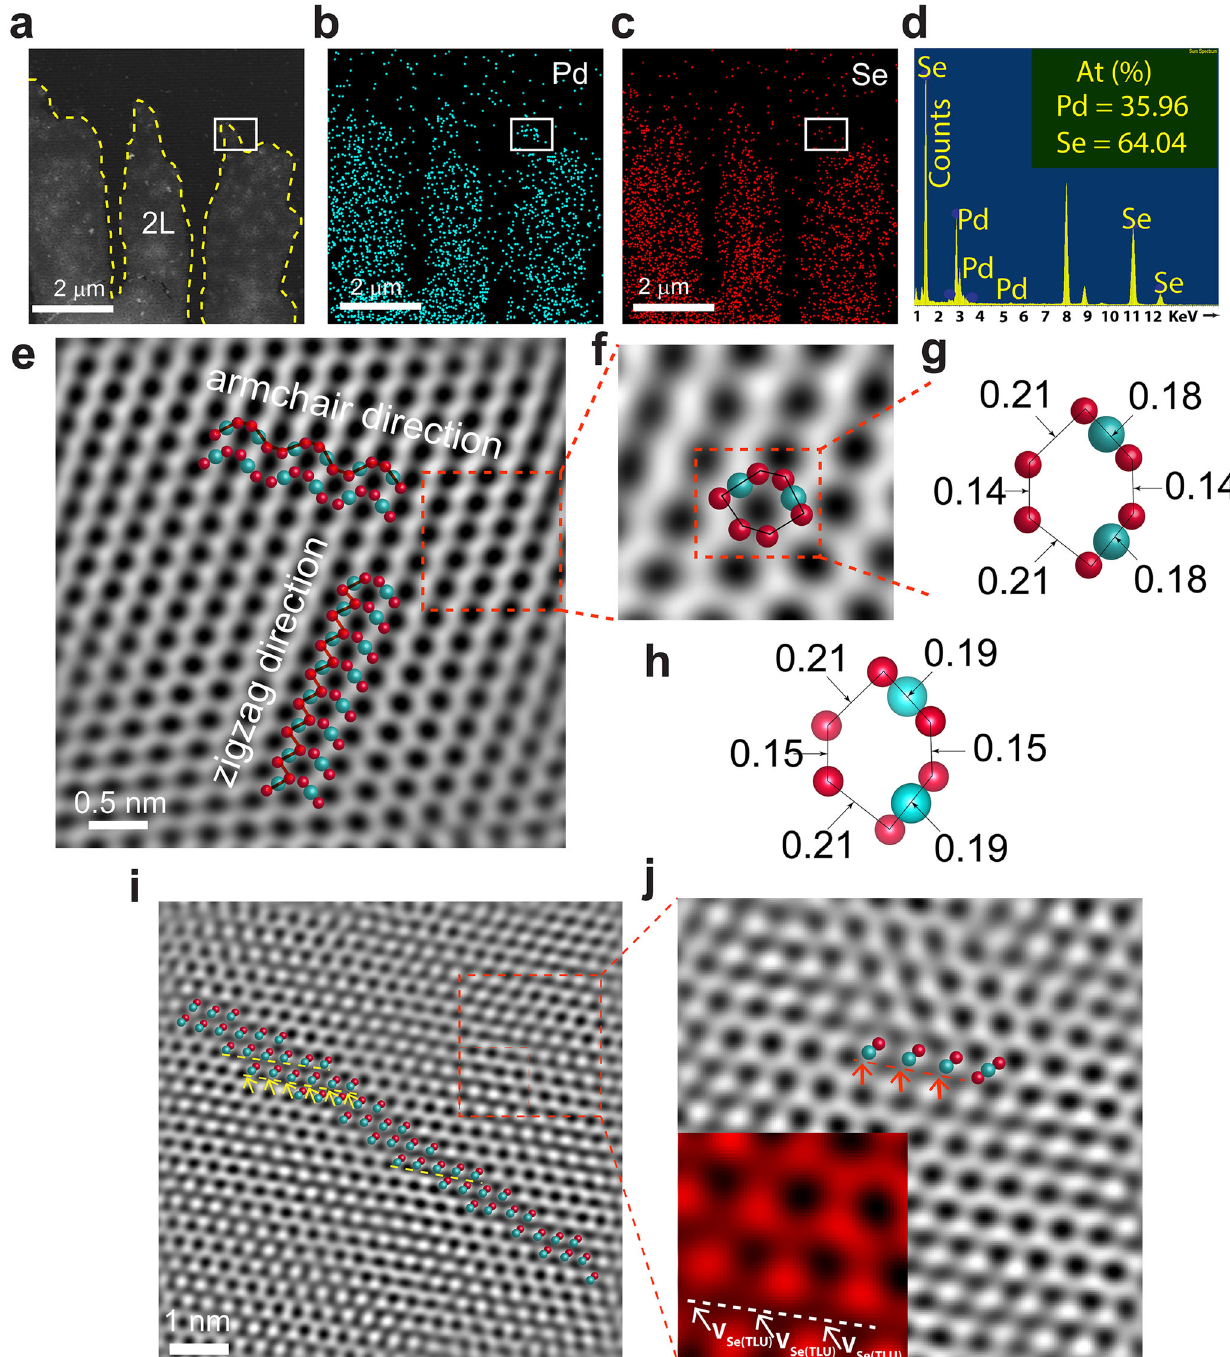
Fig. 2 TEM imaging of line defects in dendritic PdSe 2 . a Dark- fi eld TEM image of PdSe 2 dendrites, b , c the elemental distribution of Pd and Se, respectively; d the corresponding atomic percentage spectrum. e HRTEM image of defect-free 2L PdSe 2 including armchair and zigzag edges. f Magni fi ed view of HRTEM image with the atomic arrangement. g Atomic model representation with interatomic distance of experimental data. h Theoretically obtained 2D interatomic distance in the atomic model. i HRTEM image of defective 2L PdSe 2 including series of line defects. j Magni fi ed view of defective 2L PdSe 2 showing line defects; arrow indicates Se TLU vacancies,which disrupts the hexagonal